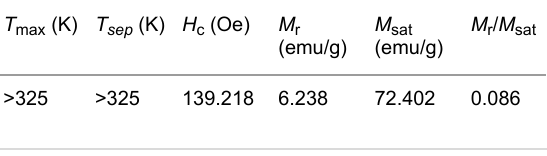
Figure 3: XRD spectrum of standard magnetite (a) and USM nanoparticles (b).